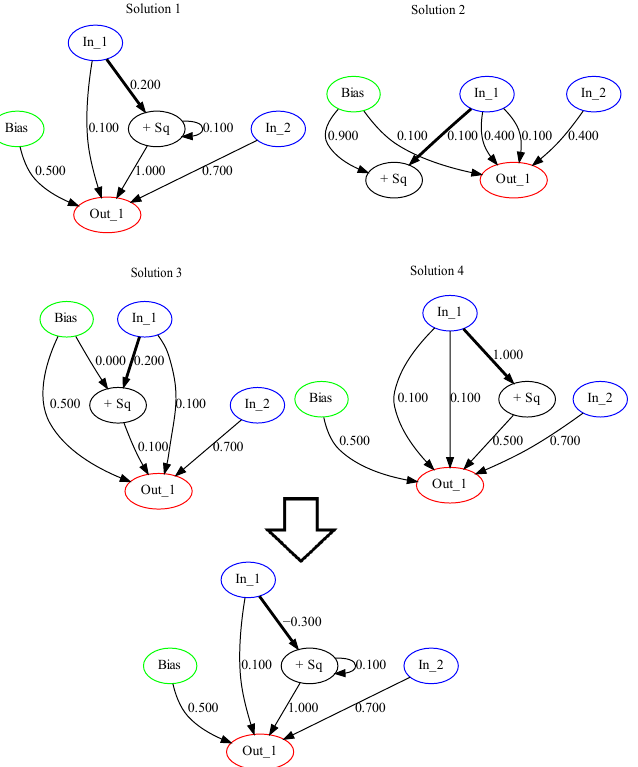
Figure 3. Visualization of DBM example from Figure